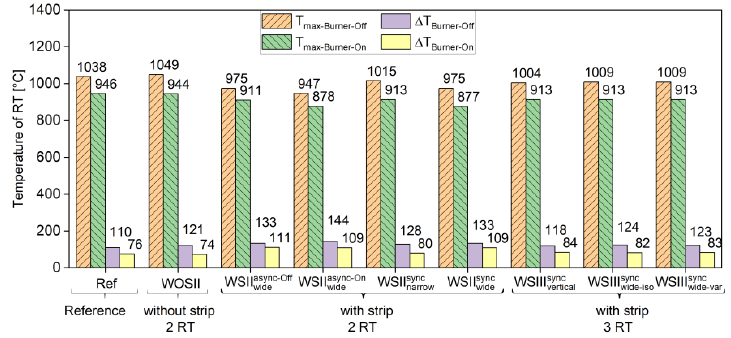
Figure 7. Comparison of the temperature distributions of all nine cases with the help of characteristic values.